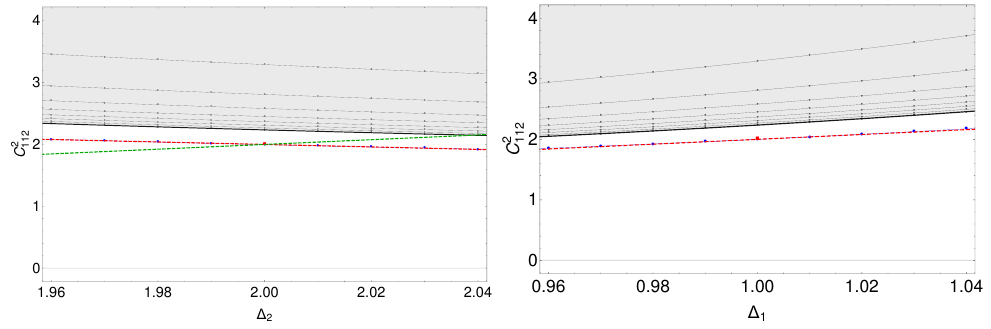
Figure 1 . Bounds on the OPE coefficient c 2 in the vicinity of the free point. In the first plot we 112 keep ∆ 1 = 1 fixed and in the second ∆ 2 = 2 . The raw data points range from Λ = 5 (upper gray line) to Λ = 29 (lower black line) in steps of 4, where Λ is the number of derivatives of the crossing equation that we used. (We show the same values of Λ in figures 2 and 3.) The blue points are an extrapolation to Λ = ∞ which fit well the first-order perturbative result (red line) around the free theory (red point). The green line corresponds to the irrelevant deformation discussed